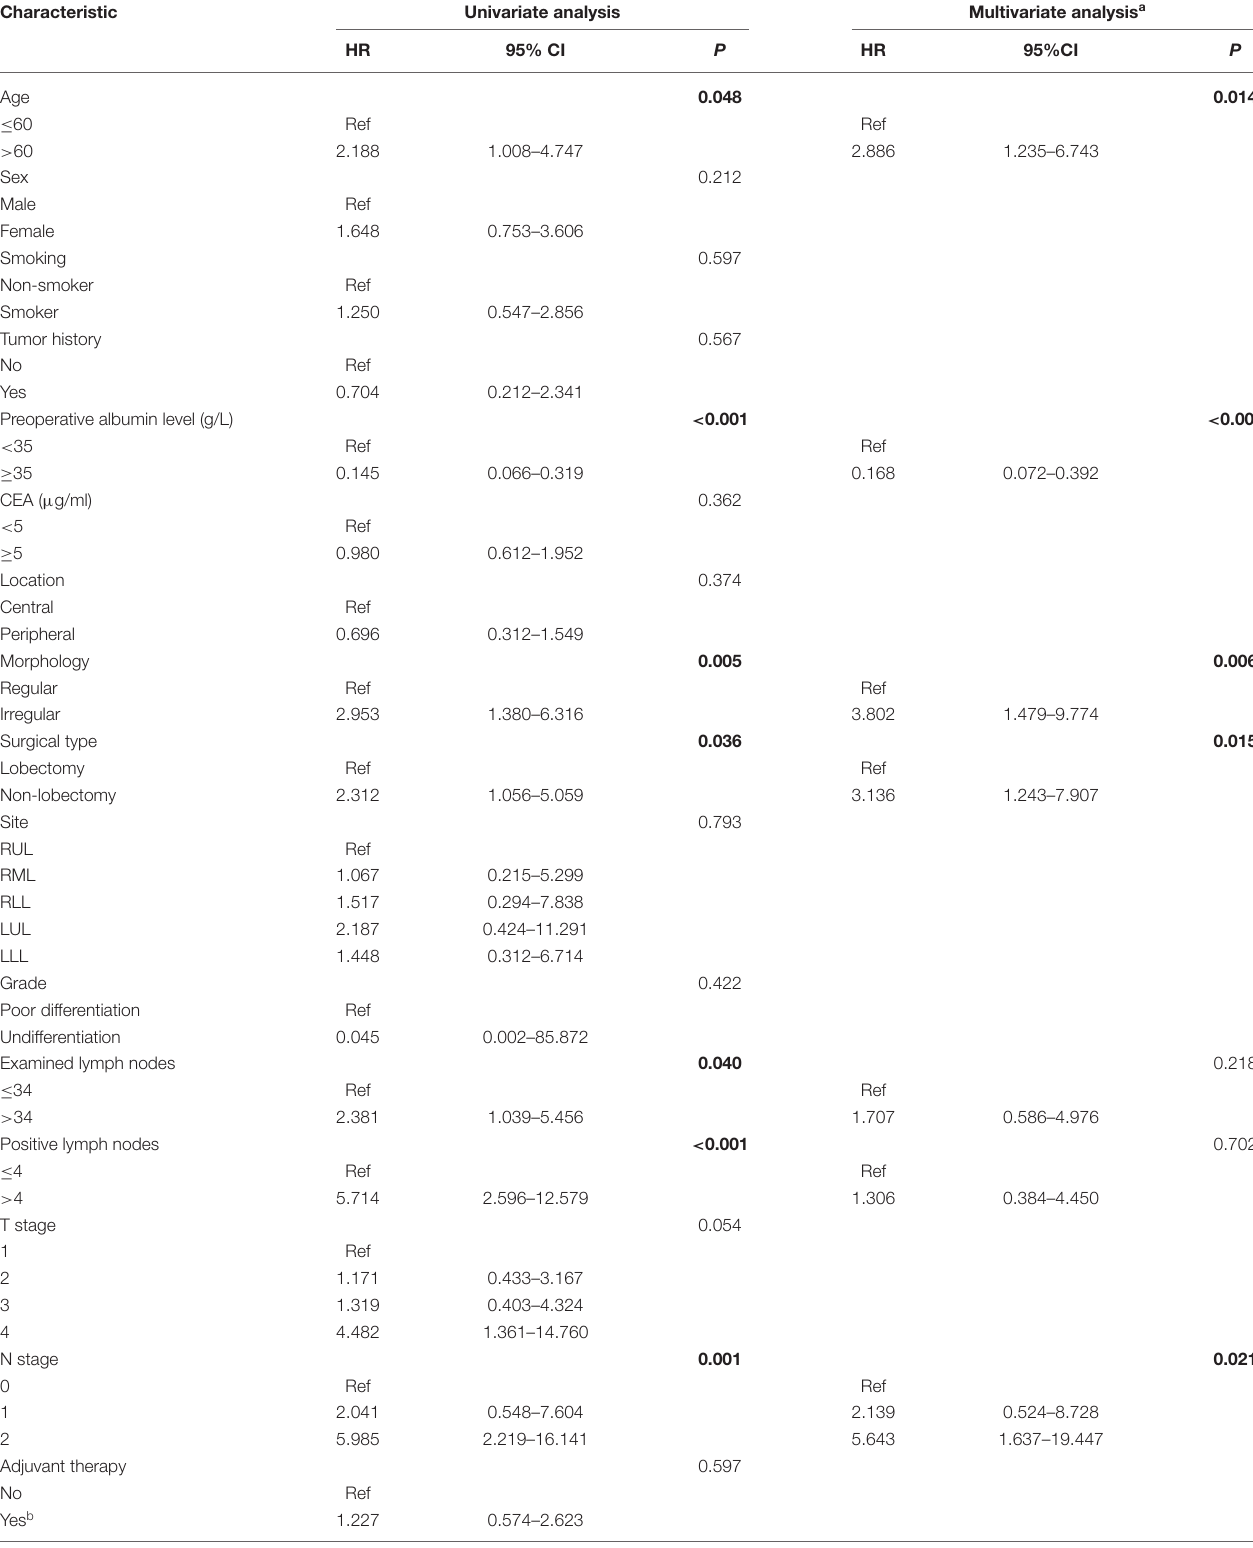
TABLE 2 | Univariate and multivariate COX proportional hazard model analysis for overall survival. Characteristic Univariate analysis Multivariate analysis